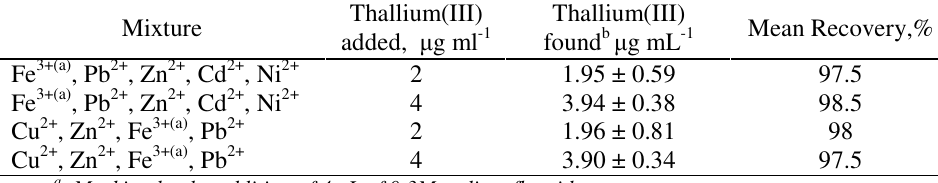
Table 6. Determination of Tl(III) in synthetic mixtures of common metal ions that usually accompany thallium in